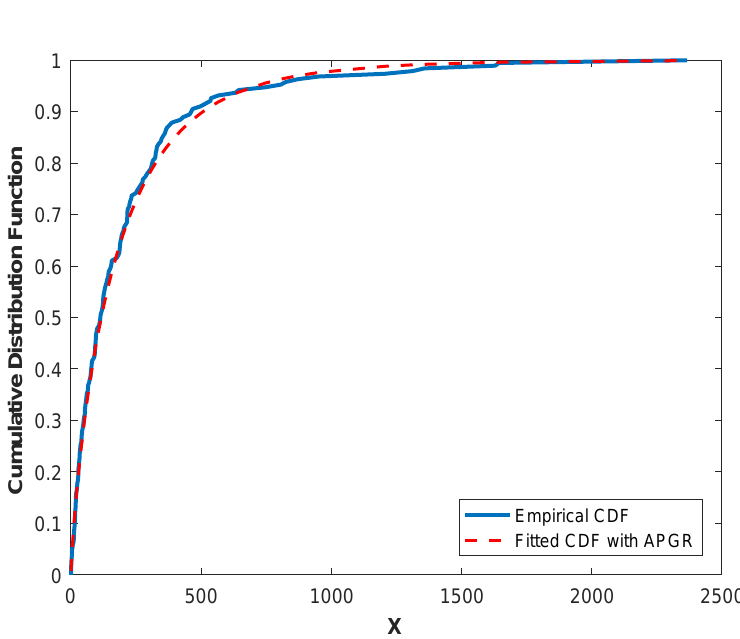
Figure 2: For the coal mining disaster data set, empirical and the fitted cdf with APGR